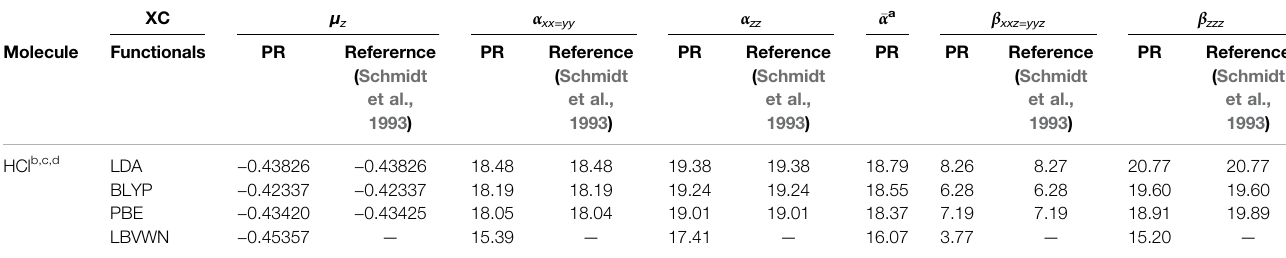
TABLE 1 | Static dipole moment μ z and FF α , (cid:2) α , β values (in a.u.) of HCl for different XC functionals. PR implies present result. More details could be found in Ghosal et al. (2018). XC